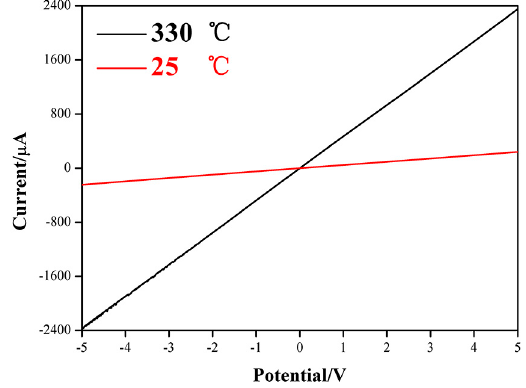
Figure 6. I - V characteristics measured when the ZnO NCs gas sensor is exposed to air under room-temperature and 330 °C.